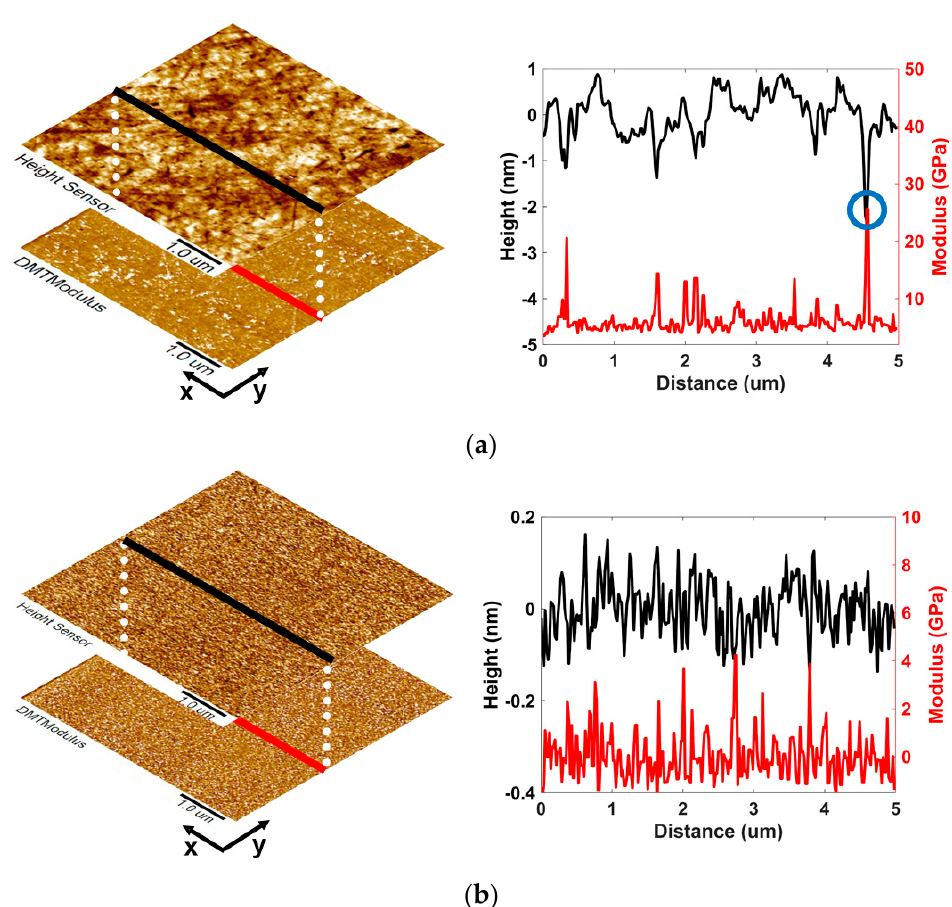
Figure 4. Schematic diagram of the relationship between surface morphology and modulus at different polishing stages: ( a ) roughly polished; ( b ) super − polished.